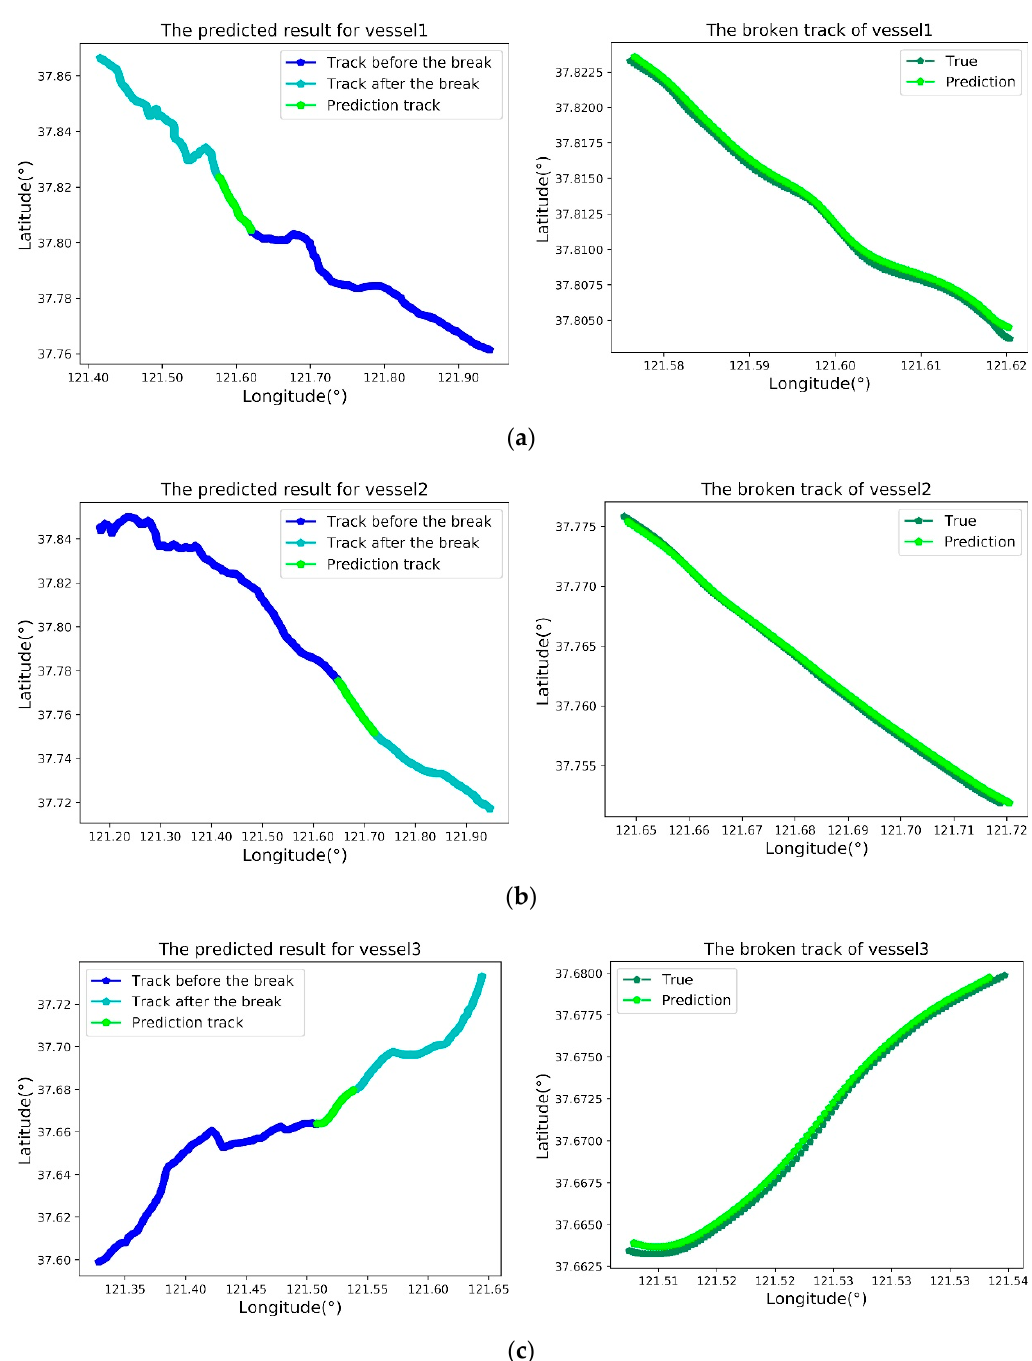
Figure 12. ( a – c ) represent the 3 broken tracks, respectively. The diagrams on the left show the predicted results of the three fractured trajectories. The blue, cyan, and green lines represent, respectively, the trace before the break, the trace after the break, and the predicted track at the fracture. The graphs on the right show the comparison between the predicted and real values at the fracture.